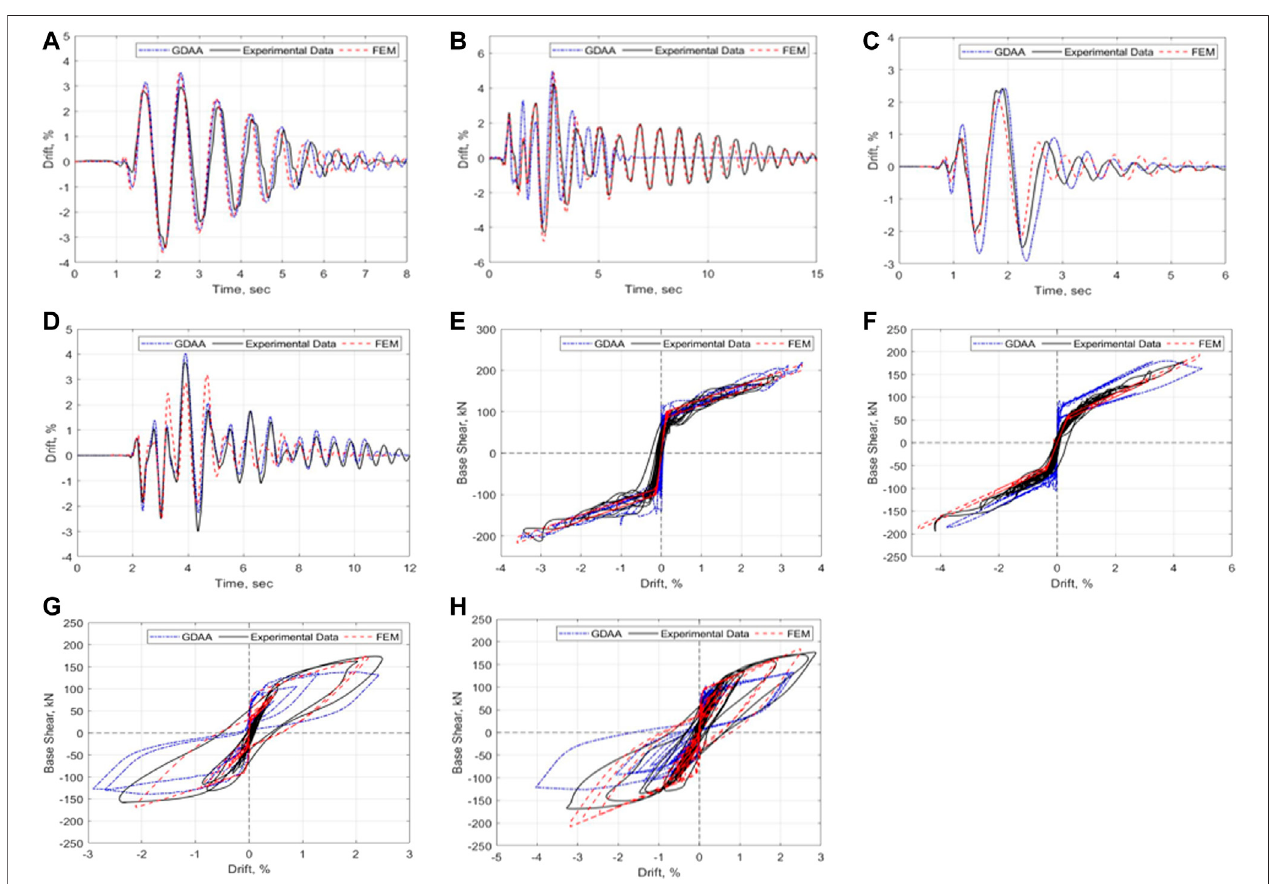
FIGURE8| GlobalresponsesofFEMandGDAAincomparisonwiththeexperimentaldata: (A) Timehistory oflateraldrift,SRW2-Sylmar; (B) Timehistoryoflateral drift, SRW2-Takatori; (C) Timehistory of lateral drift, PreWEC2-Sylmar; (D) Time history of lateral drift, PreWEC2-Takatori; (E) base shear vs. lateral drift, SRW2-Sylmar; (F) Base shear vs. lateral drift, SRW2-Takatori; (G) Base shear vs. lateral drift, PreWEC2-Sylmar; (H) Base shear vs. lateral drift, PreWEC2-Takatori.